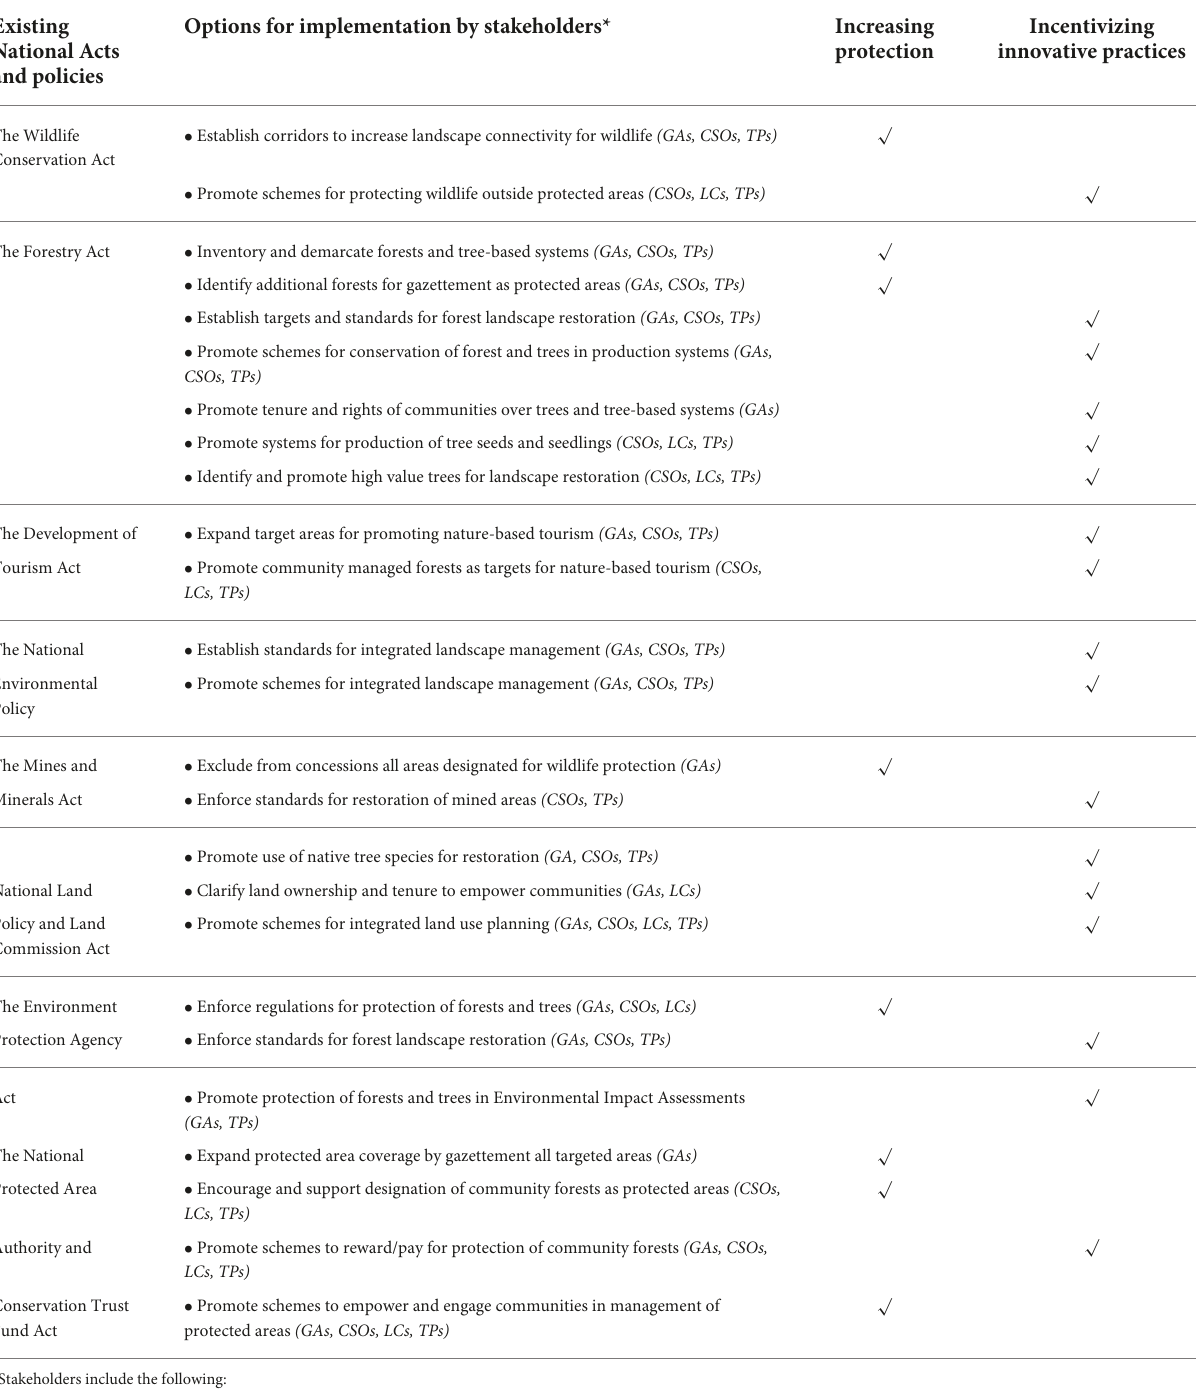
TABLE 2 Harnessing existing policies to advance the landscape